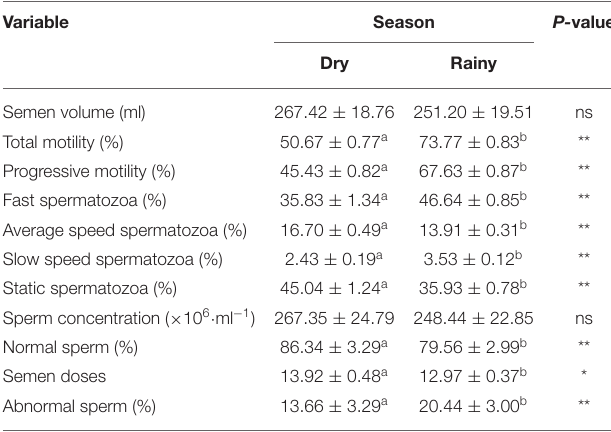
TABLE 2 | Overall changes in seminal characteristics (mean ± SEM) of boar ejaculates during the experiment.